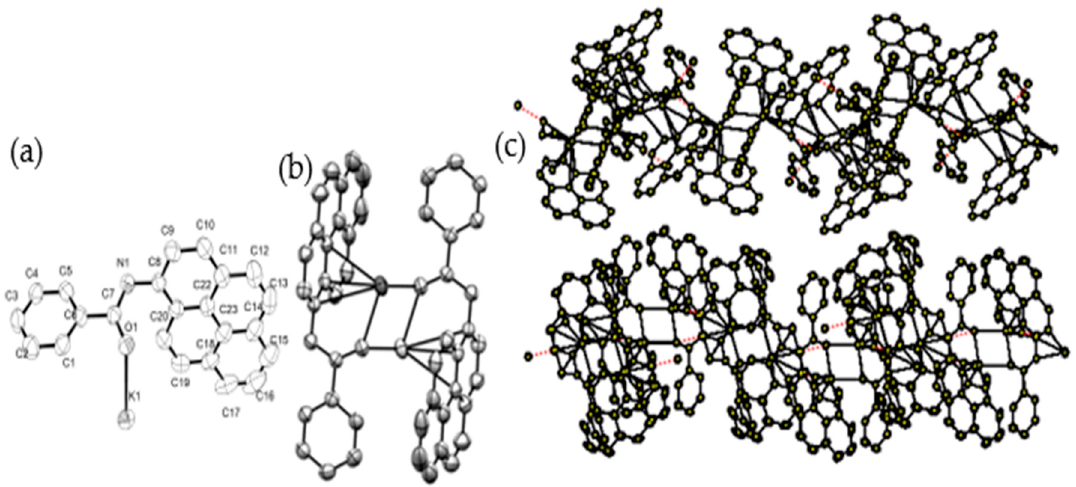
Figure 1. ( a ) Ortep drawing of structure of K2 , ellipsoids are shown at the 30% probability level ( left ). ( b ) A section of the packing diagram in K2 ( right ).